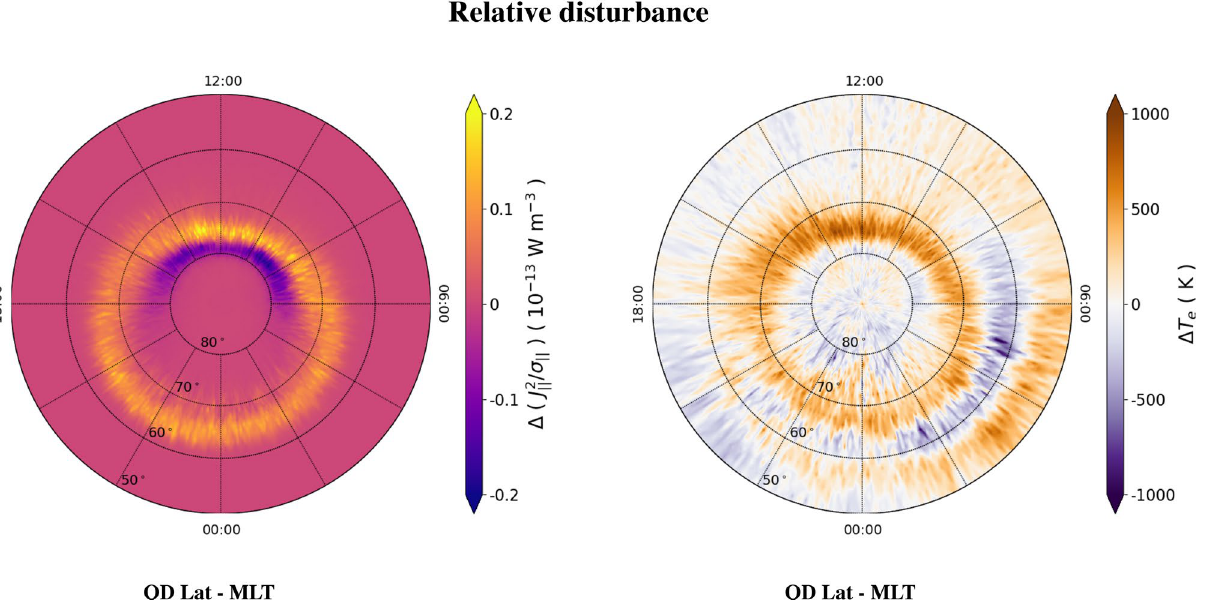
Figure 3. Difference maps in QD latitude vs MLT coordinates of dissipated power density, J 2 || /σ || , (left panel) and electron temperature, T e , (right panel) in the Northern hemisphere. Difference maps are